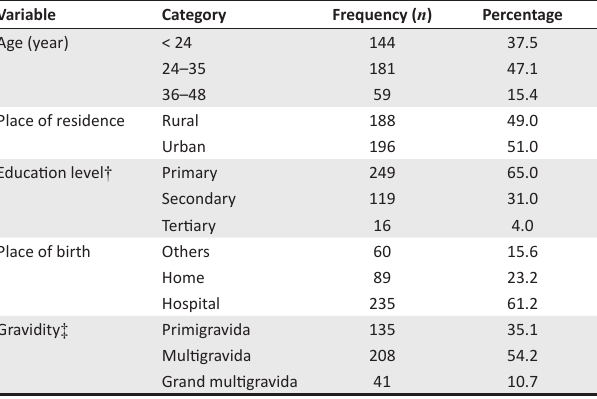
TABLE 1: Demographic characteristics of participants attending the antenatal clinic at Kyazanga Health Centre IV, South Western Uganda, between April 2021 and June 2021.